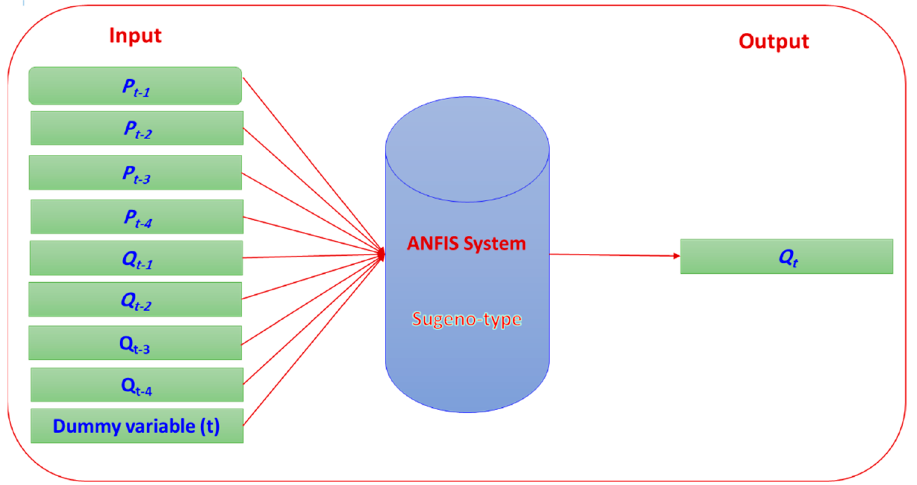
Figure 4. An adaptive neuro-fuzzy inference system (ANFIS) architecture for inflow forecasting.